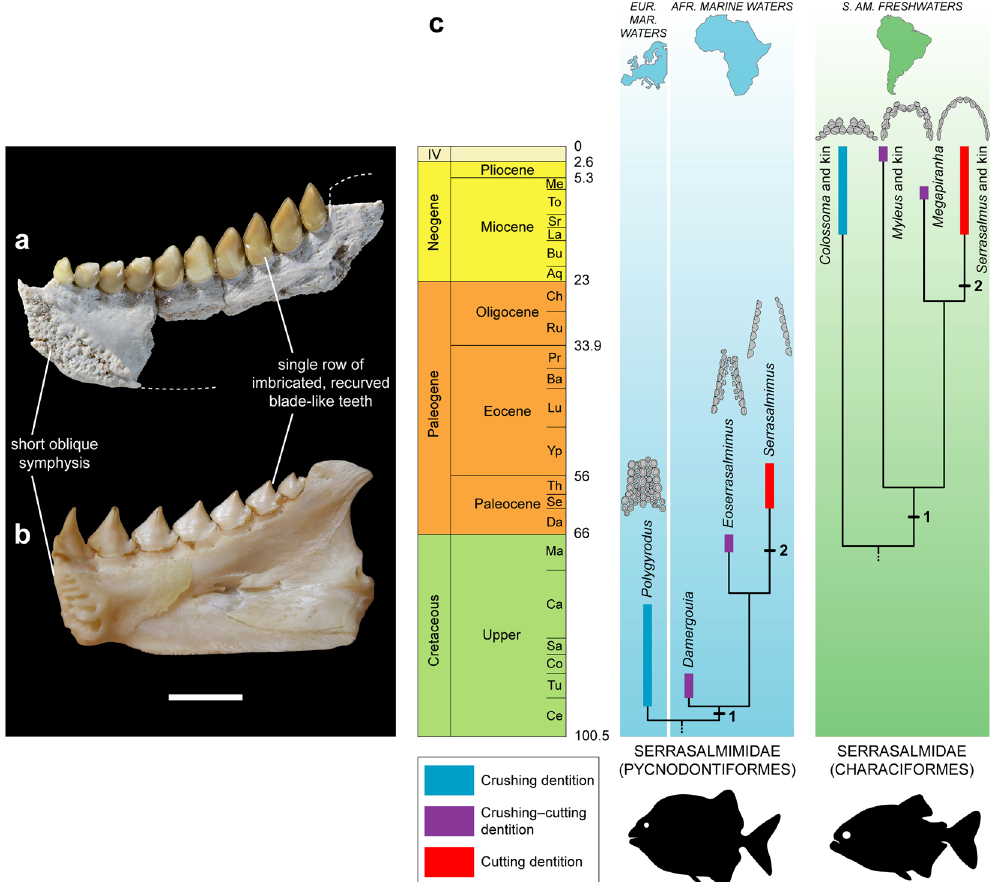
Figure 4. Convergence between serrasalmimid and serrasalmid fishes. ( a , b) Comparison between a right prearticular (MHNM KHG 159) of Serrasalmimus secans gen. et sp. nov. ( a ) and a right dentary of extant Serrasalmus rhombeus ( b ) from French Guyana (unnumbered specimen from P.-Y. Lebail’s collection, Fish Physiology and Genomics Institute, INRA LGPG, Rennes), in medial view (note that the articular and the angular are still in articulation in the posterior part of the mandible). ( c) Phylogenetic relationships between the four genera of serrasalmimid fishes (Pycnodontiformes) (supported by our phylogenetic analysis; see Figs 3 and S4), and convergent evolution with serrasalmid fishes (Characiformes). A congruent series of transformations in dental morphology and arrangement is observed in serrasalmimids and serrasalmids. In both groups, the transition from crushing to cutting dentitions (upper jaws are represented here, with vomerine dentition for serrasalmimids and premaxillary dentition for serrasalmids) is characterized by the successive acquisition of two key features: labiolingually compressed teeth (character 1) and single row of blade-like teeth (character 2). See Supplementary Fig. S7 for further information about the serrasalmid dentitions represented here. Stratigraphic distribution and time-calibrated phylogeny of the serrasalmid genera from refs 22,28 . Stage abbreviations are as follows: Aq, Aquitanian; Ba, Bartonian; Bu, Burdigalian; Ca, Campanian; Ce, Cenomanian; Ch, Chattian; Co, Coniacian; Da, Danian; La, Langhian; Lu, Lutetian; Ma, Maastrichtian; Me, Messinian; Pr, Priabonian; Ru, Rupelian; Sa, Santonian; Se, Selandian; Sr, Serravalian; Th, Thanetian; To, Tortonian; Tu, Turonian; Yp, Ypresian. Scale bar, 10 mm. ( a , photograph by Lilian Cazes –